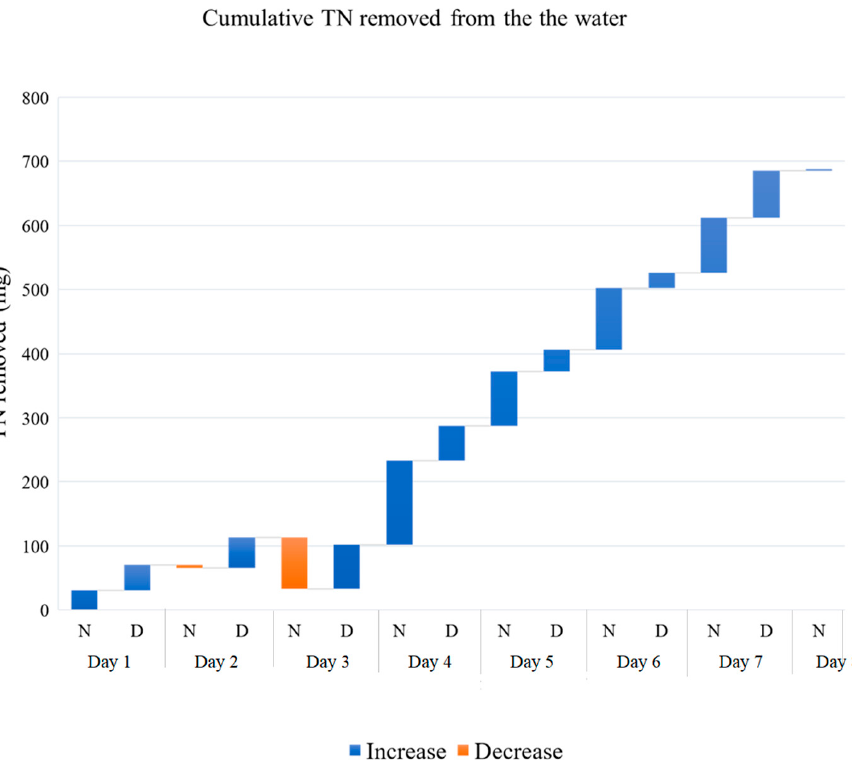
Figure 6. Cumulative Total Nitrogen removed from 70 L of aquaculture effluent every 12 h. N (Night) indicates the Total Nitrogen removed between 8:00 pm and 8:00 am; D (Day) indicates the Total Nitrogen removed between 8:00 am and 8:00 pm. The graph shows the average of three repli ‐ cates.